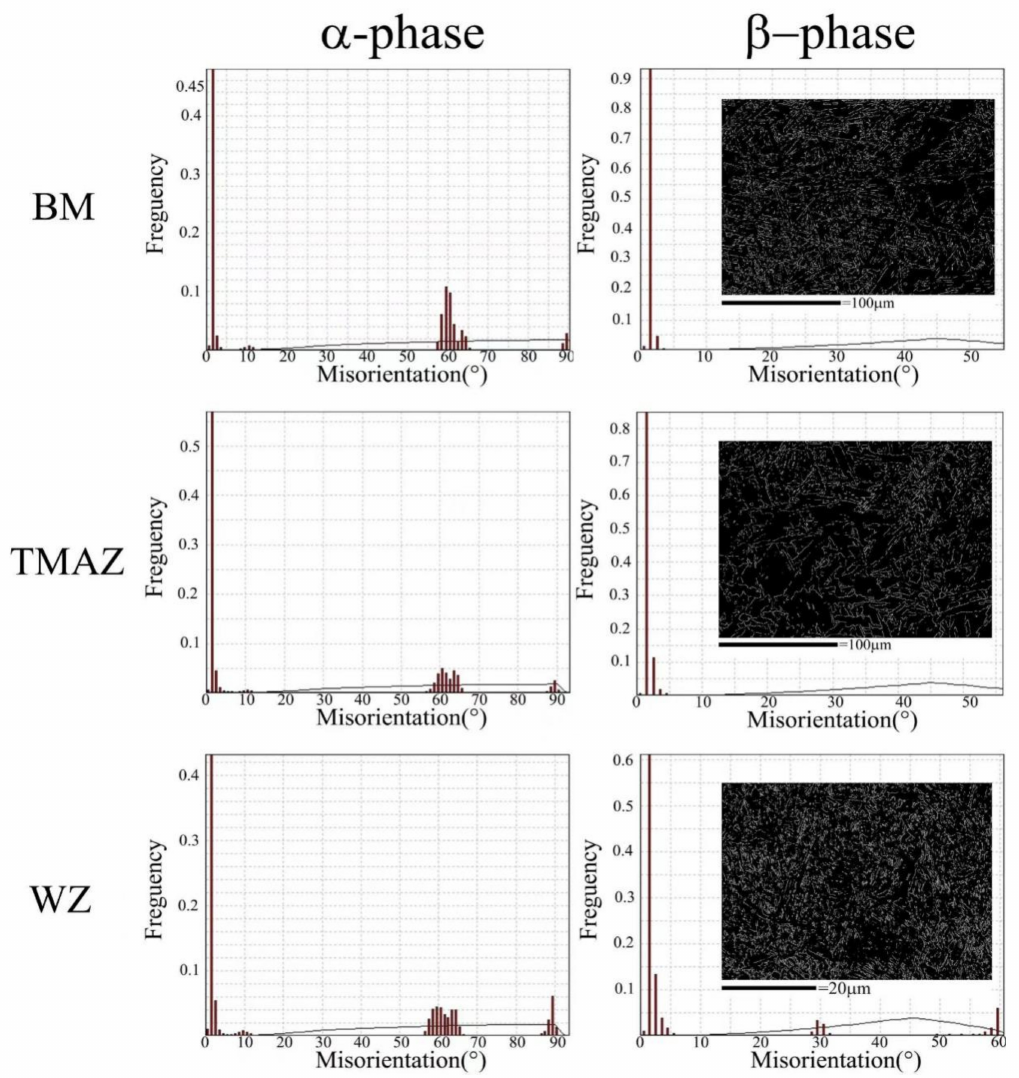
Figure 6. Misorientation angle distribution of grain boundary for the different zones of the IFW